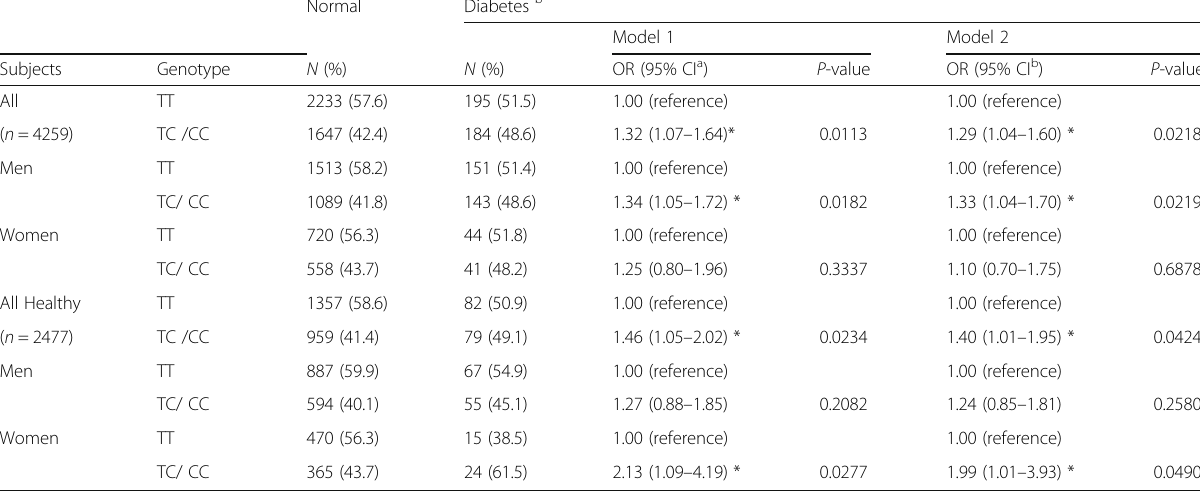
Table 3 Odds ratios (OR) of the polymorphic rs17782313 MC4R genotypes for diabetes in the